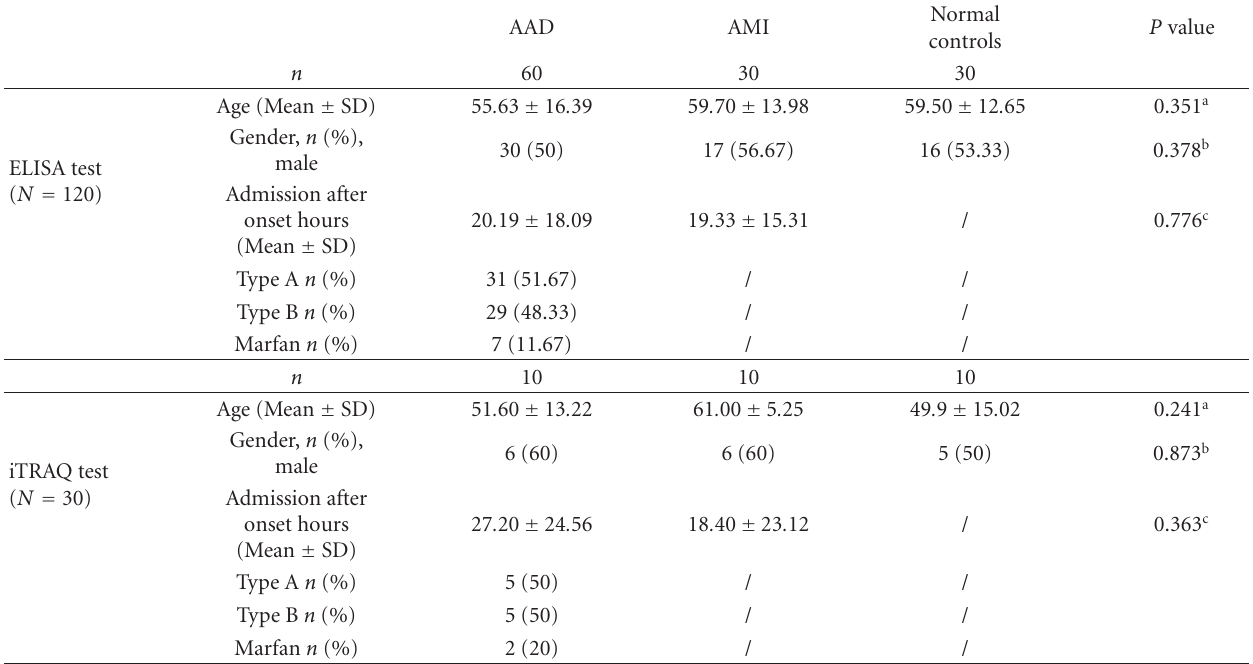
Table 1: Clinical characteristics in three